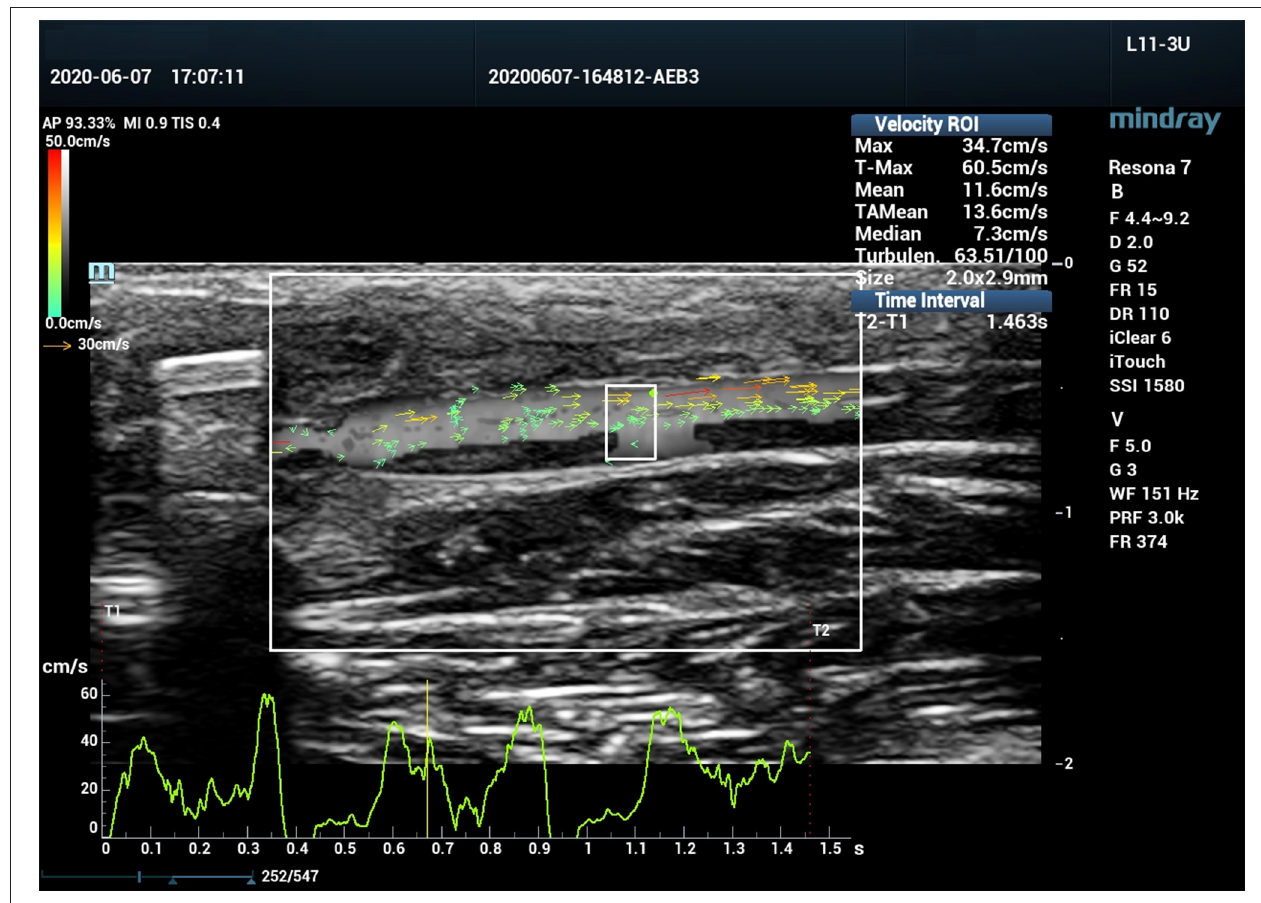
FIGURE 2 | Vector flow imaging (V Flow) of a canine femoral artery.